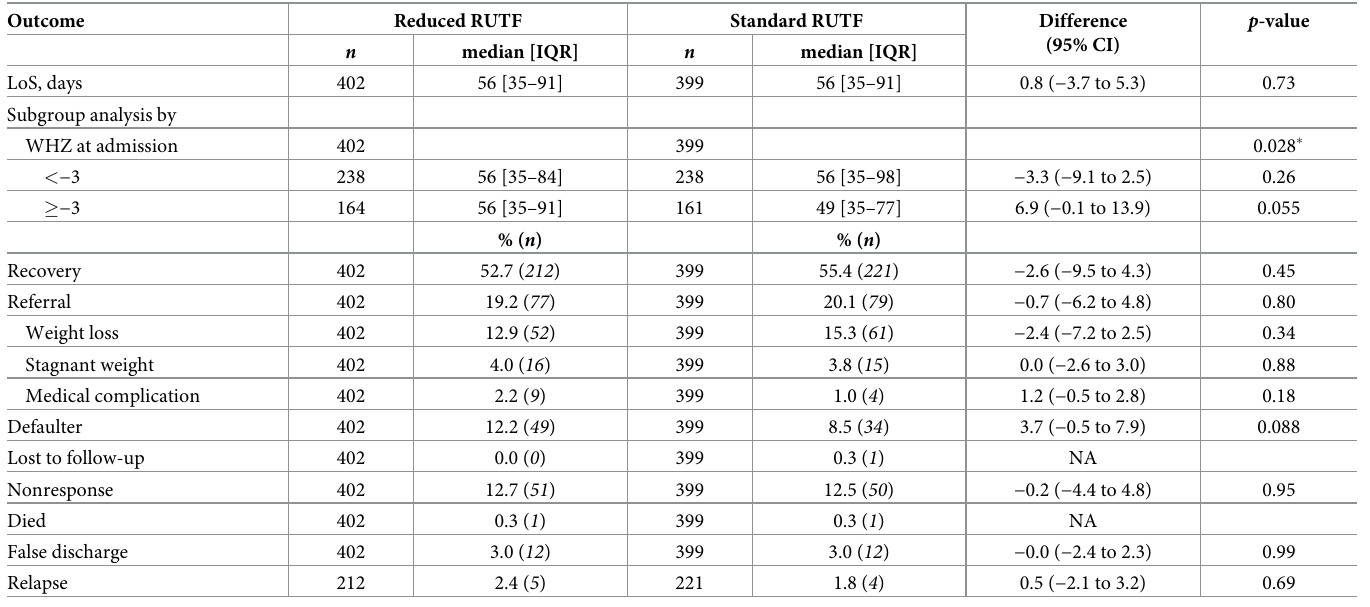
Table 5. Programmatic outcomes of children with SAM randomised to reduced or standard RUTF dose with risk difference (95% CI) in unadjusted ITT analysis.